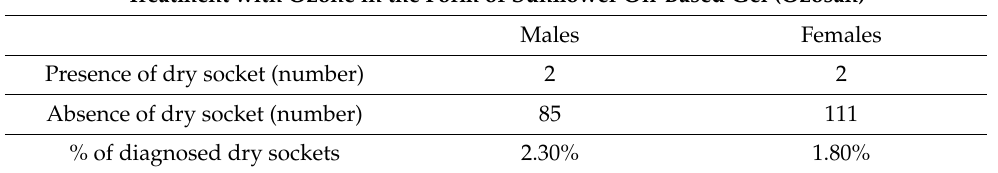
Table 3. The table displays the number of diagnosed dry sockets in female or male patients after treatment with ozone in the form of sunflower oil-based gel (Ozosan) or placebo gel. The incidence percentage of dry sockets was calculated with respect to the number of female patients (113) or male patients (87) with third molars extracted. The * symbol denotes a statistically significant difference ( p < 0.05) between the two treatments, as calculated using the chi-square test. Treatment with Ozone in the Form of Sunflower Oil-Based Gel (Ozosan)